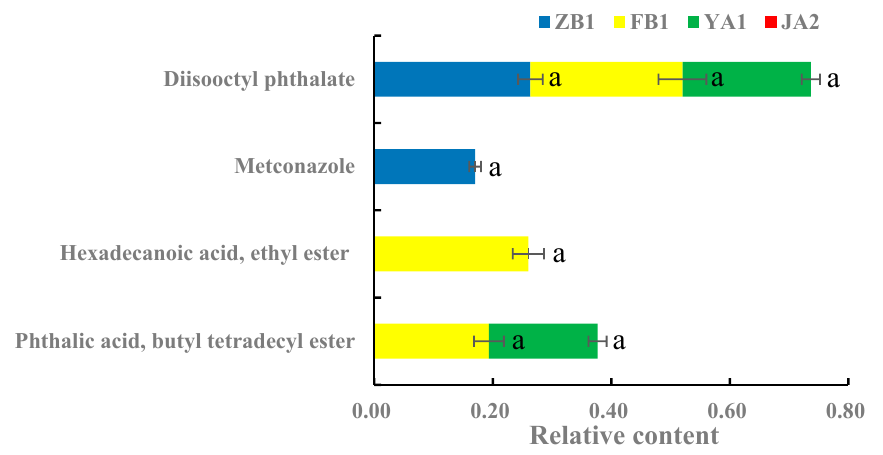
Figure 3. The relative content of toxic components in D. officinale in four different regions from GC-MS data (ZB1, FB1, YA1 and JA1). The letters a and b indicate significant difference at p < 0.05. Since the sample data is 0, b was not indicated in the figure.